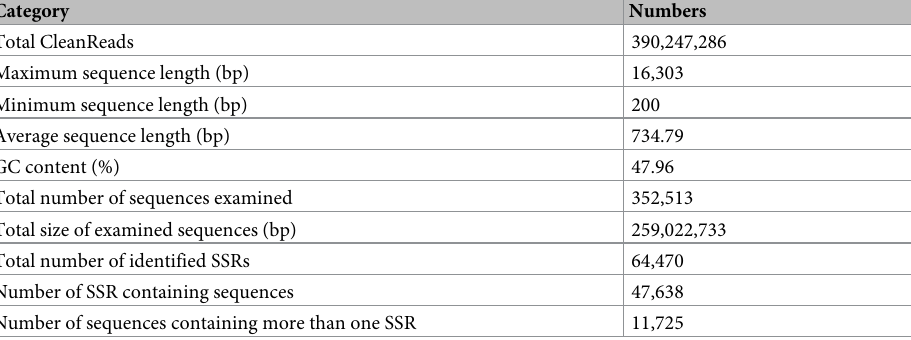
Table 2. Occurrence of microsatellites in E . ophiuroides transcriptome